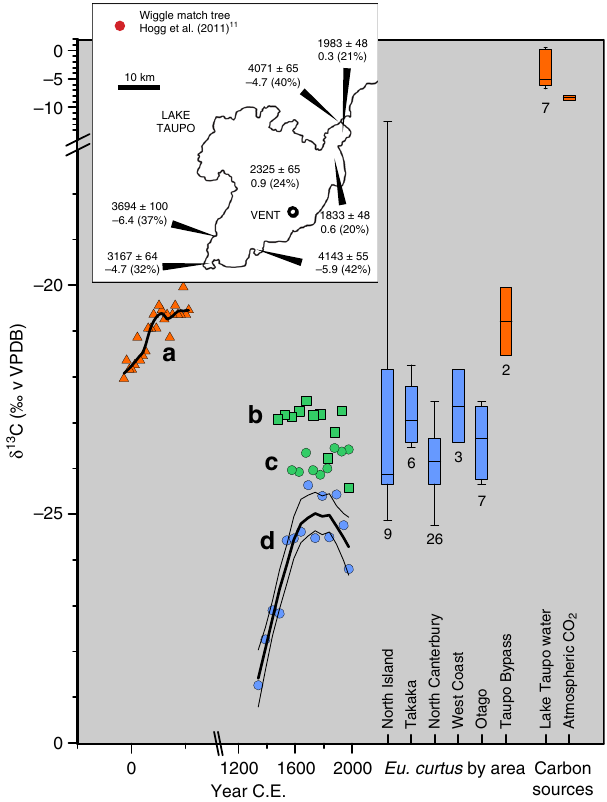
Fig. 2 Comparisons between carbon stable isotopic ratios ( δ 13 C) of the wiggle match tree rings with other trees at various distances from the eruption vent (see Fig. 1 for colour code), of bone gelatin of a species of herbivorous bird (Dinornithiformes: Emeidae: Euryapteryx curtus ), and for Taupo lake water. Values of δ 13 C in trunk wood cellulose and in the other organisms indicate the availability of magmatic ( 14 C-free) carbon dioxide for photosynthetic uptake by trees. a Wiggle-match tree 11 , b , c two matai (Podocarpaceae: Prumnopitys taxifolia ) trees growing in the open at ‘ Glenore ’ , Hawkes Bay, 68 km east of vent, d rimu (Podocarpaceae: Dacrydium cupressinum ) tree, Fox River, Paparoa National Park, West Coast, South Island. Box-whisker plots (maximum, minimum, median, lower and upper quartiles; numbers, sample sizes): bone gelatin δ 13 C for Euryapteryx curtus (from areas within (red, Taupo Bypass, <60 km from vent) and (blue) remote from TVZ; Lake Taupo DIC 20 , and current atmospheric CO 2 . Note axis breaks. Inset: Lake Taupo: conventional radiocarbon ages of DIC in lake water (with measurement s.d., δ 13 C values, and percentage of in fi nite age carbon contaminating dated sample)